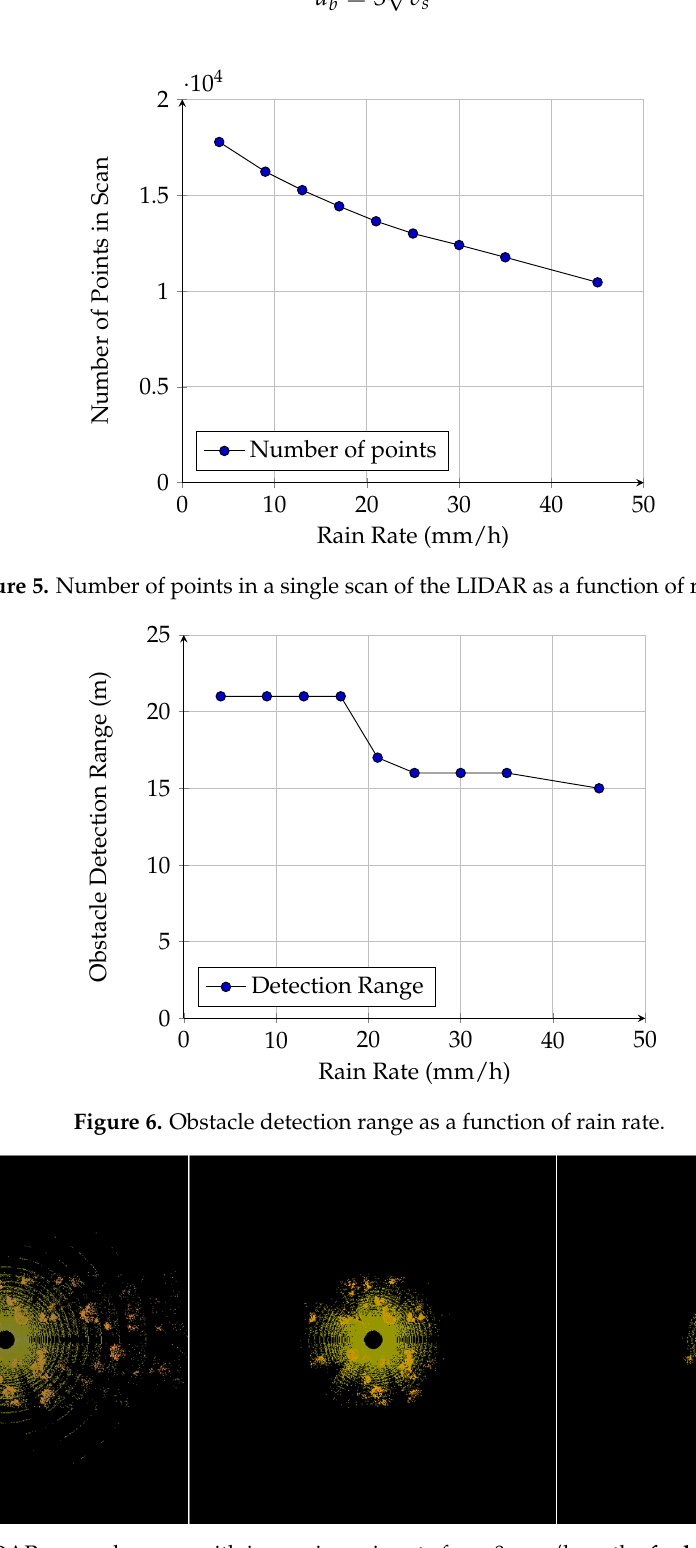
Figure 7. LIDAR range decrease with increasing rain rate from 0 mm/h on the far left , 9 mm/h in the middle , and 17 mm/h on the right